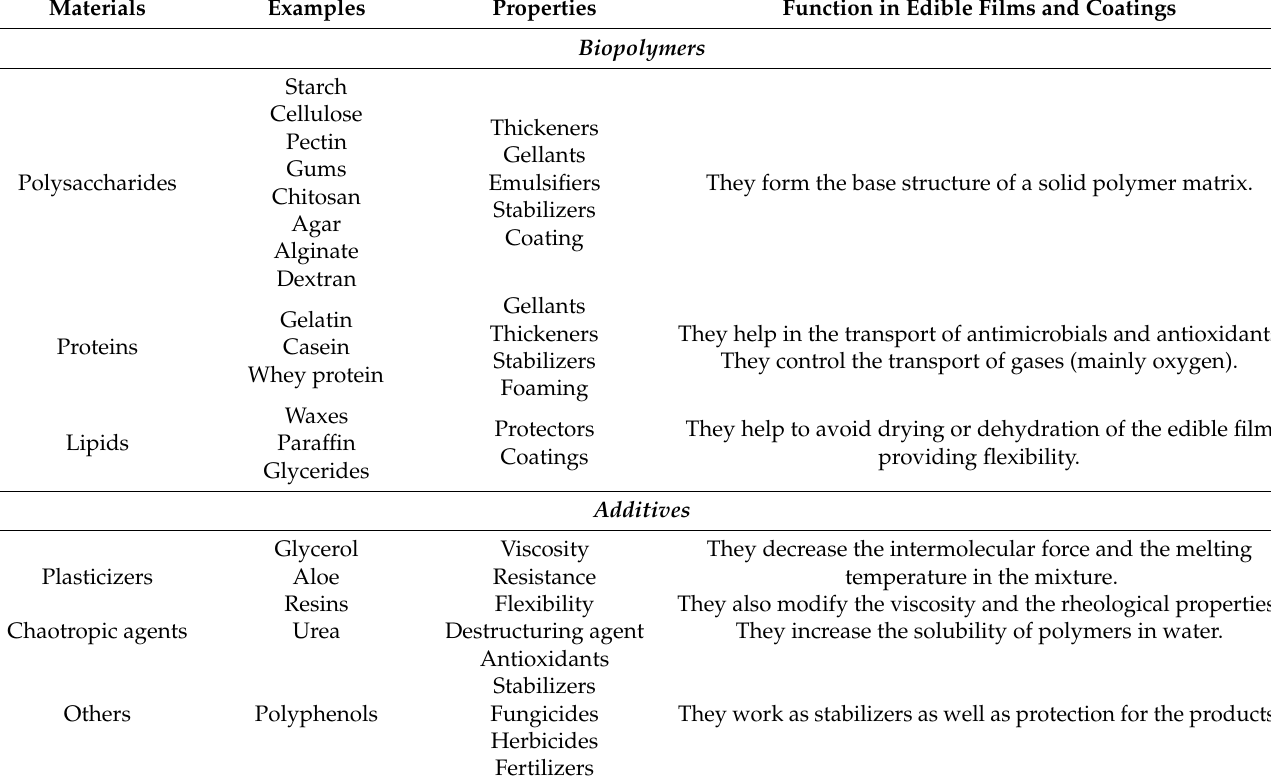
Table 2. Main materials used and functionality in the manufacture of edible films and coatings